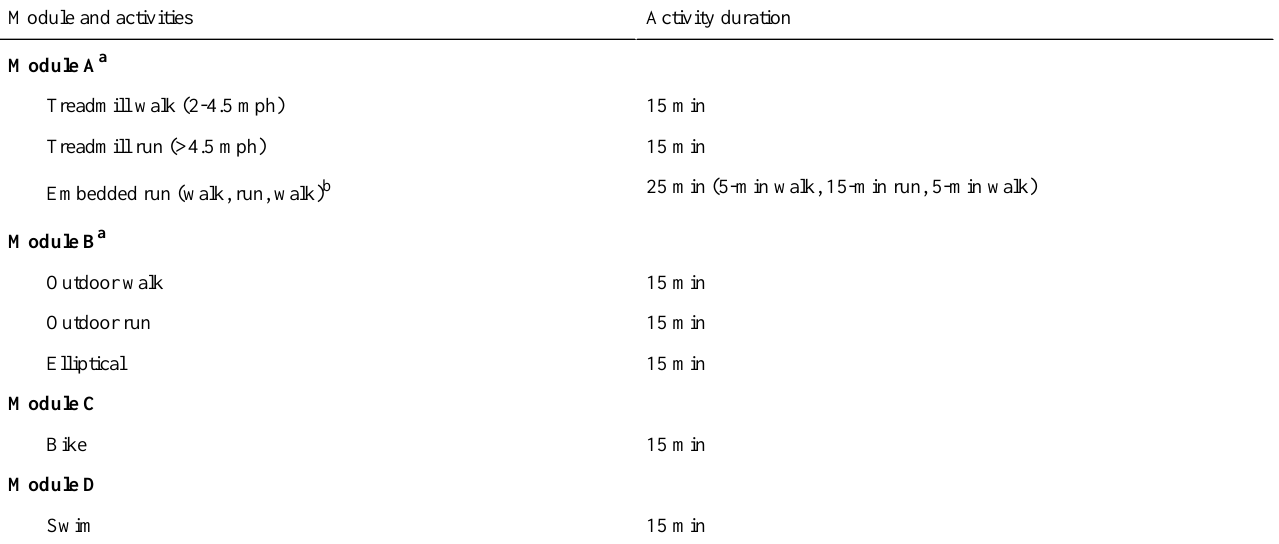
Table 1. Description and duration of activities in each of the experimental modules.